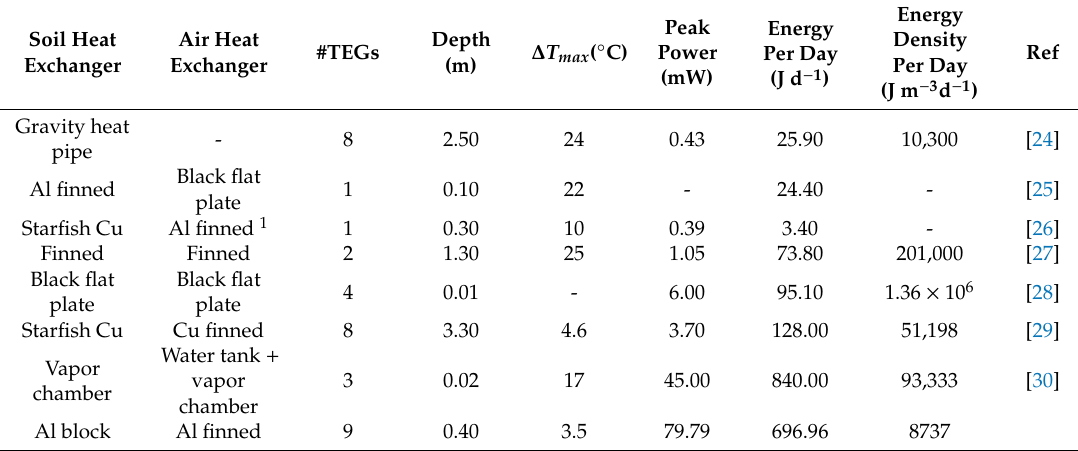
Table 1. Main features of various solar thermoelectric generators (STEG) devices. Data of last row correspond to the present